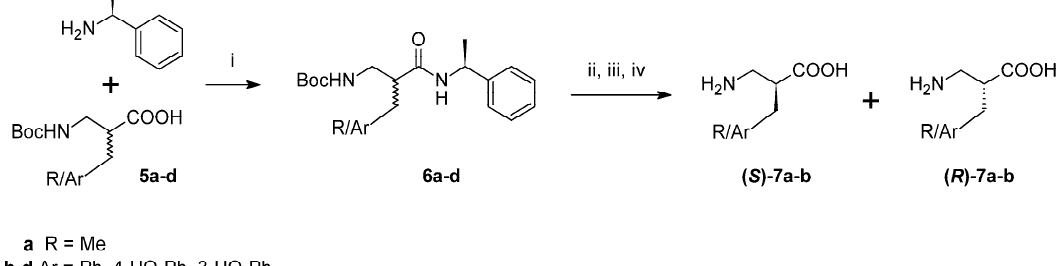
Table 1. Binding affinity of the studied